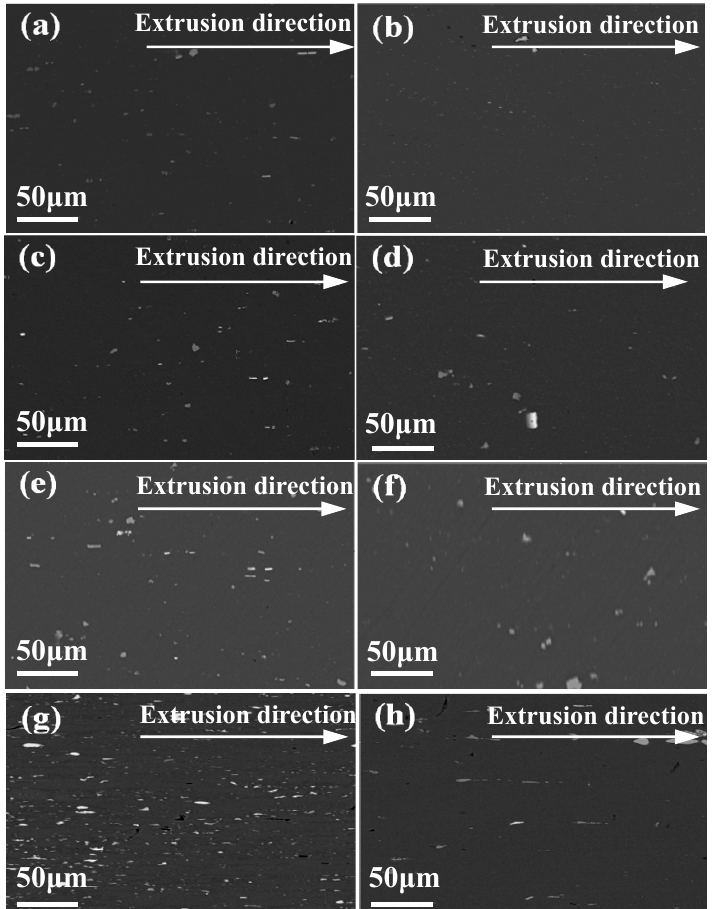
Figure 4. Back-scattered electron (BSE) images of the alloys at different states: ( a ) as-extruded Alloy 1, ( b ) as-quenched Alloy 1, ( c ) as-extruded Alloy 2, ( d ) as-quenched Alloy 2, ( e ) as-extruded Alloy 3, ( f ) as-quenched Alloy 3, ( g ) as-extruded Alloy 4, ( h ) as-quenched Alloy 4.